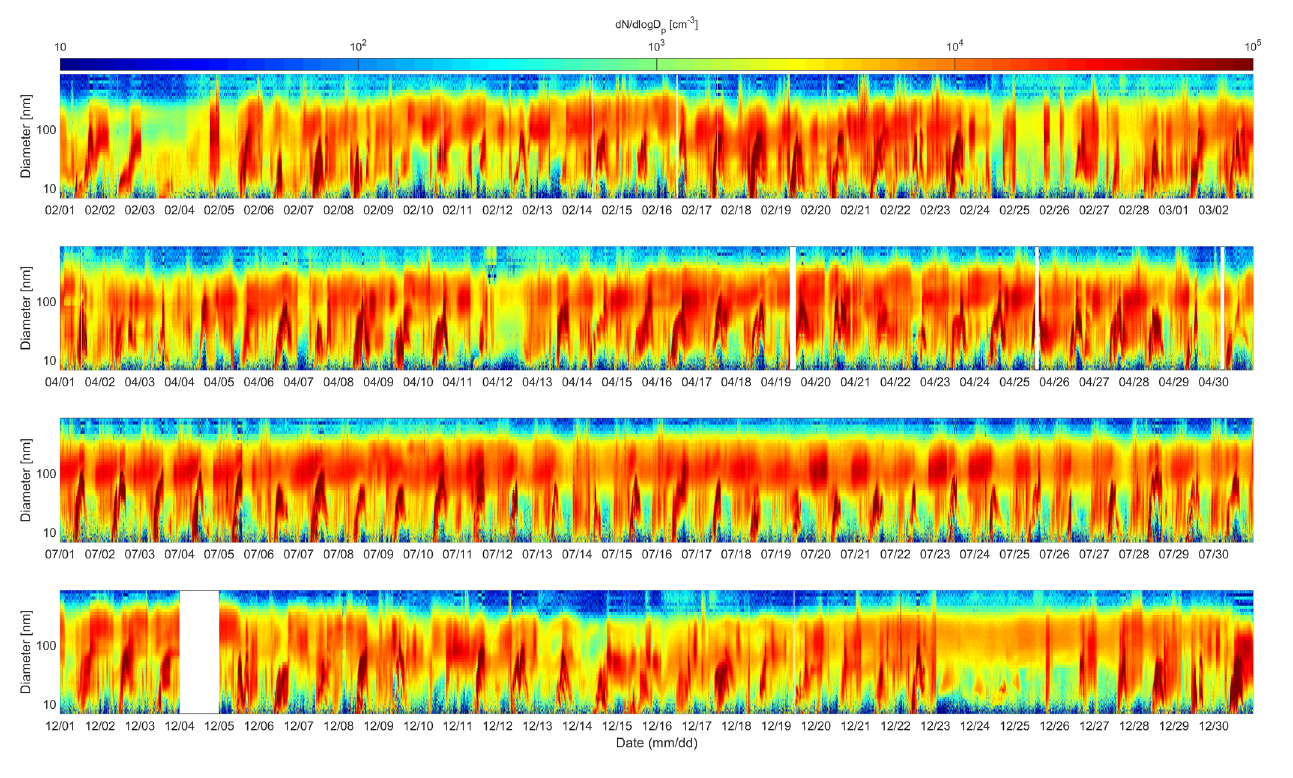
Figure A1. Time series of particle number size distributions during February 2013, April 2014, July 2013 and December 2013 illustrating the high frequency and typical characteristics of NPF, as well as periods of nonevent and undefined days, e.g., during 23–27 December 2013. The shown time series were selected so that they would cover different seasons with continuous data availability.